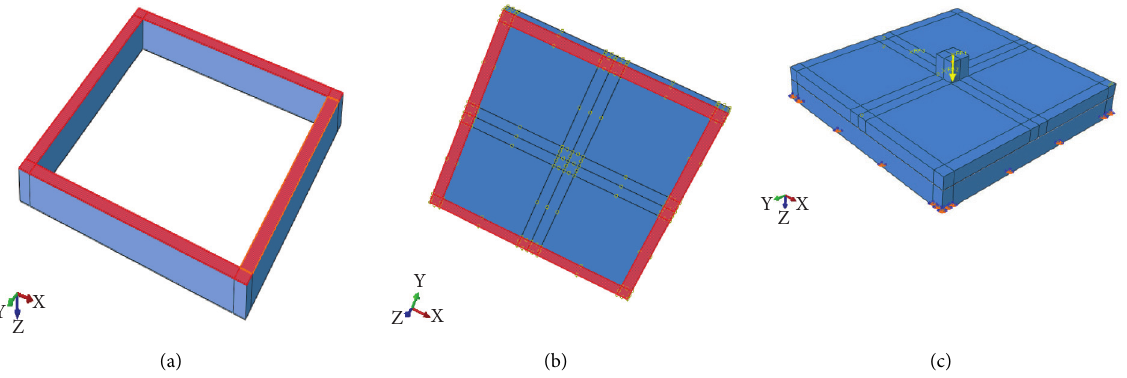
Figure 4: 3D finite element model of RC slab. (a) Determination of the elements of support. (b) Meshing of the concrete slab. (c) Meshing of the steel reinforcements.